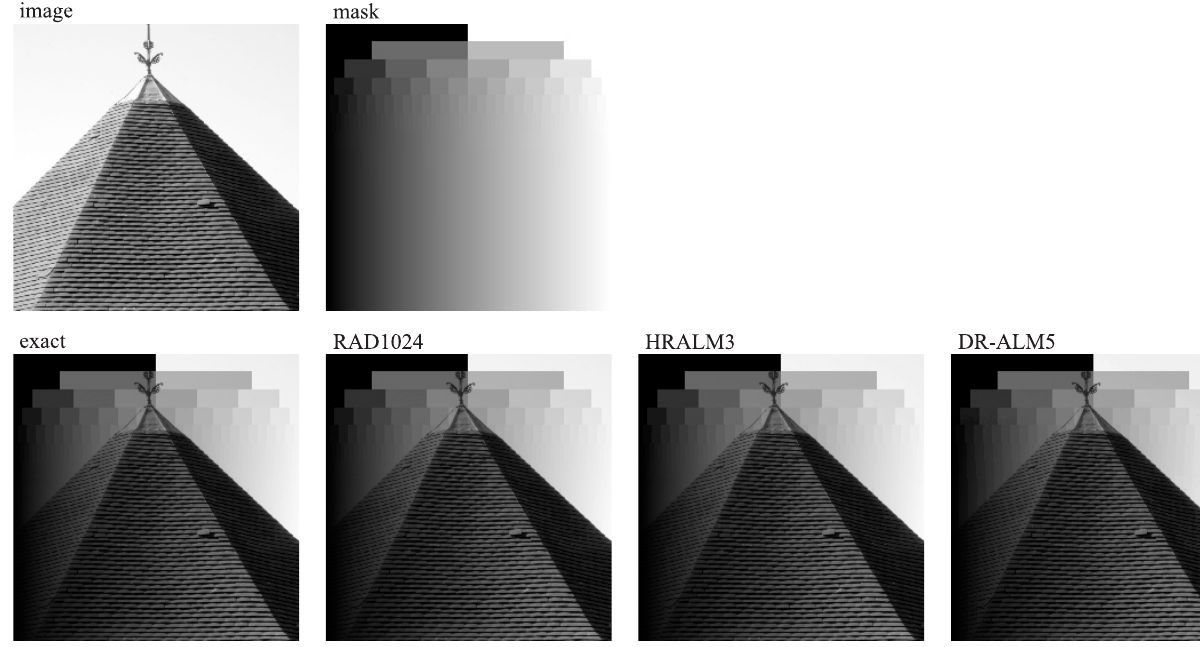
Figure 9. The roof image multiplication with gray level bits mask for selected approximate